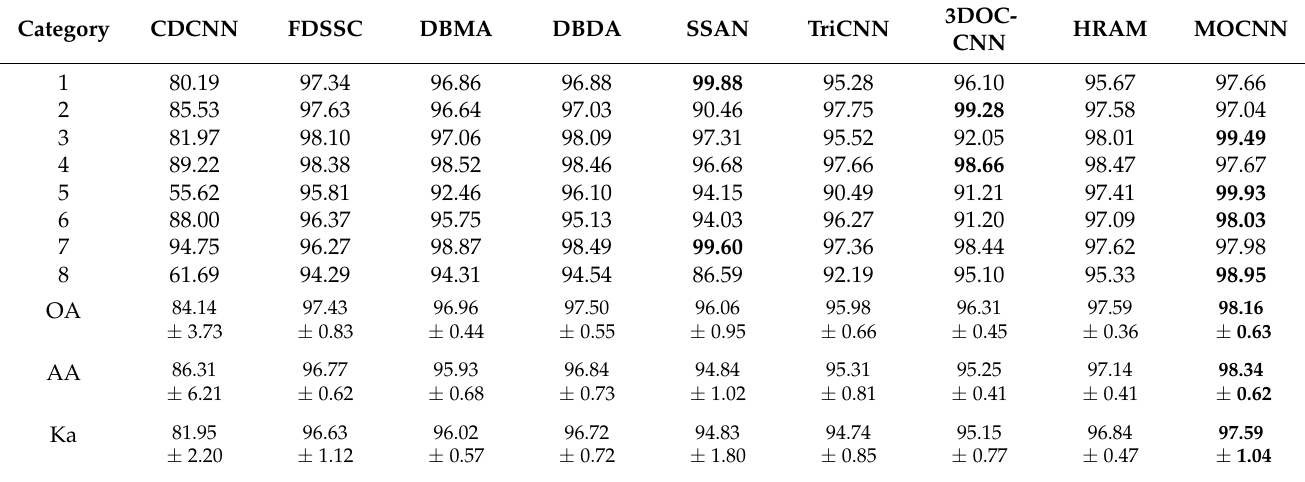
Table 10. Quantitative comparison of the CDCNN [30], FDSSC [31], DBMA [34], DBDA [35], SSAN [24], TriCNN [48], 3DOC-CNN [37], HRAM [49], and MOCNN on